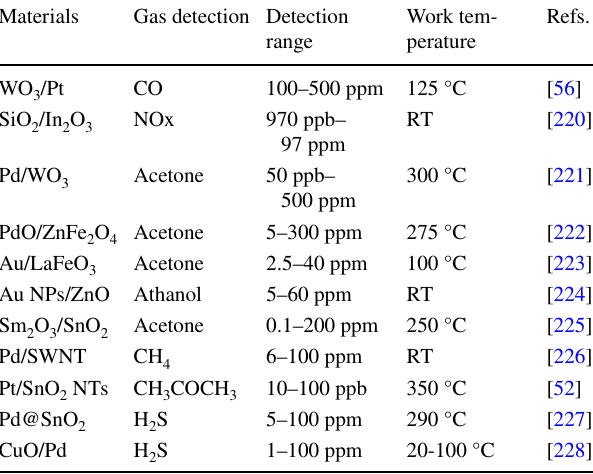
Table 1 Representative works based on catalytic effects